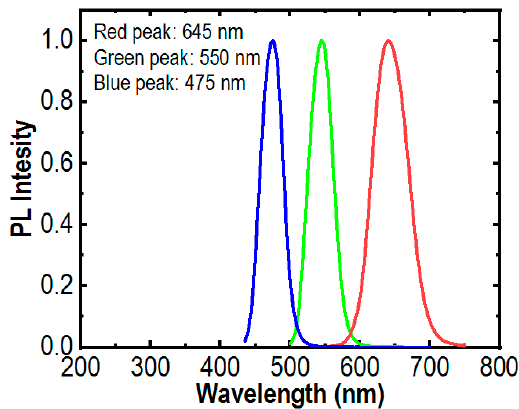
Figure 2. Photoluminescence spectra of the red, green, and blue (RGB) InGaN / AlGaN nanowire µ LEDs measured at room temperature.